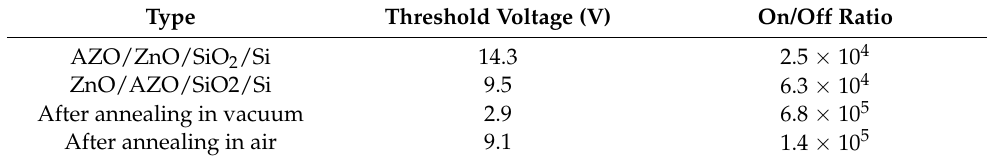
Table 1. The field-effect parameters of the TFTs with various active layers and annealing